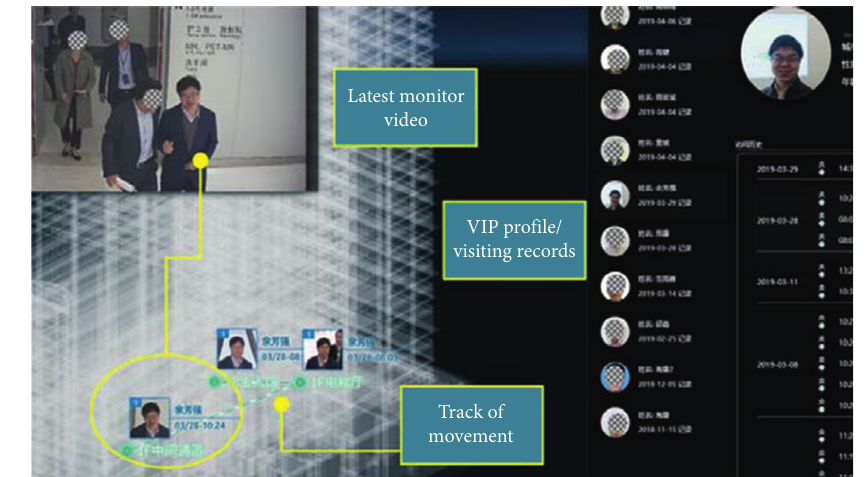
Figure 9: Security system integration (the face images of security camera snapshots have been authorized by corresponding